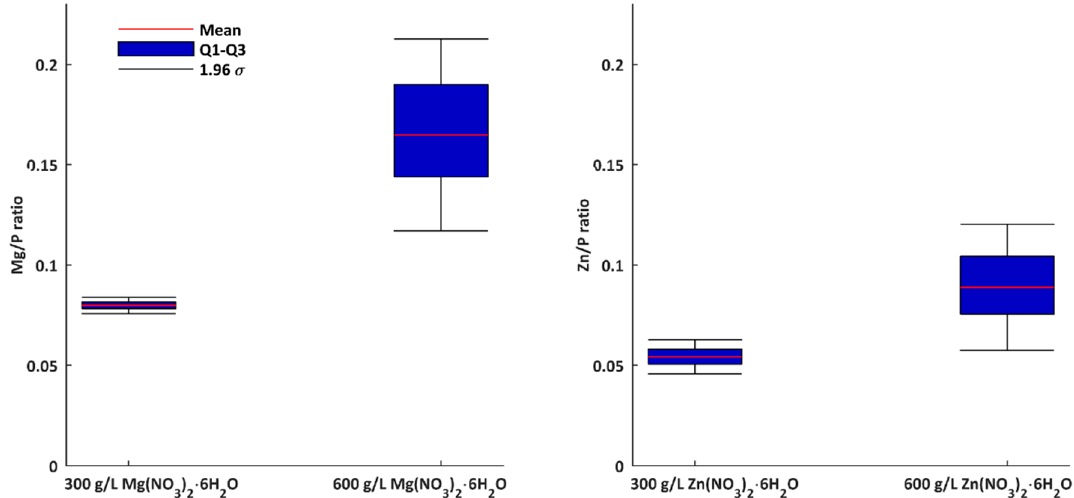
Figure 3. EDS results of coatings after PEO processing obtained in electrolytes composed of Mg(NO 3 ) 2 ·6H 2 O and Zn(NO 3 ) 2 ·6H 2 O in H 3 PO 4 at concentrations of 300 g/L and 600 g/L at a voltage of 450